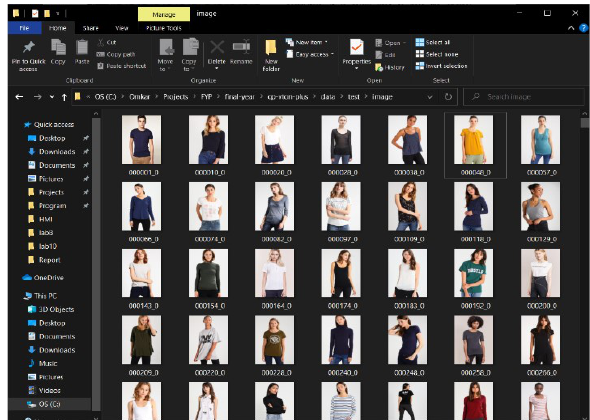
Fig. 3. Target human images